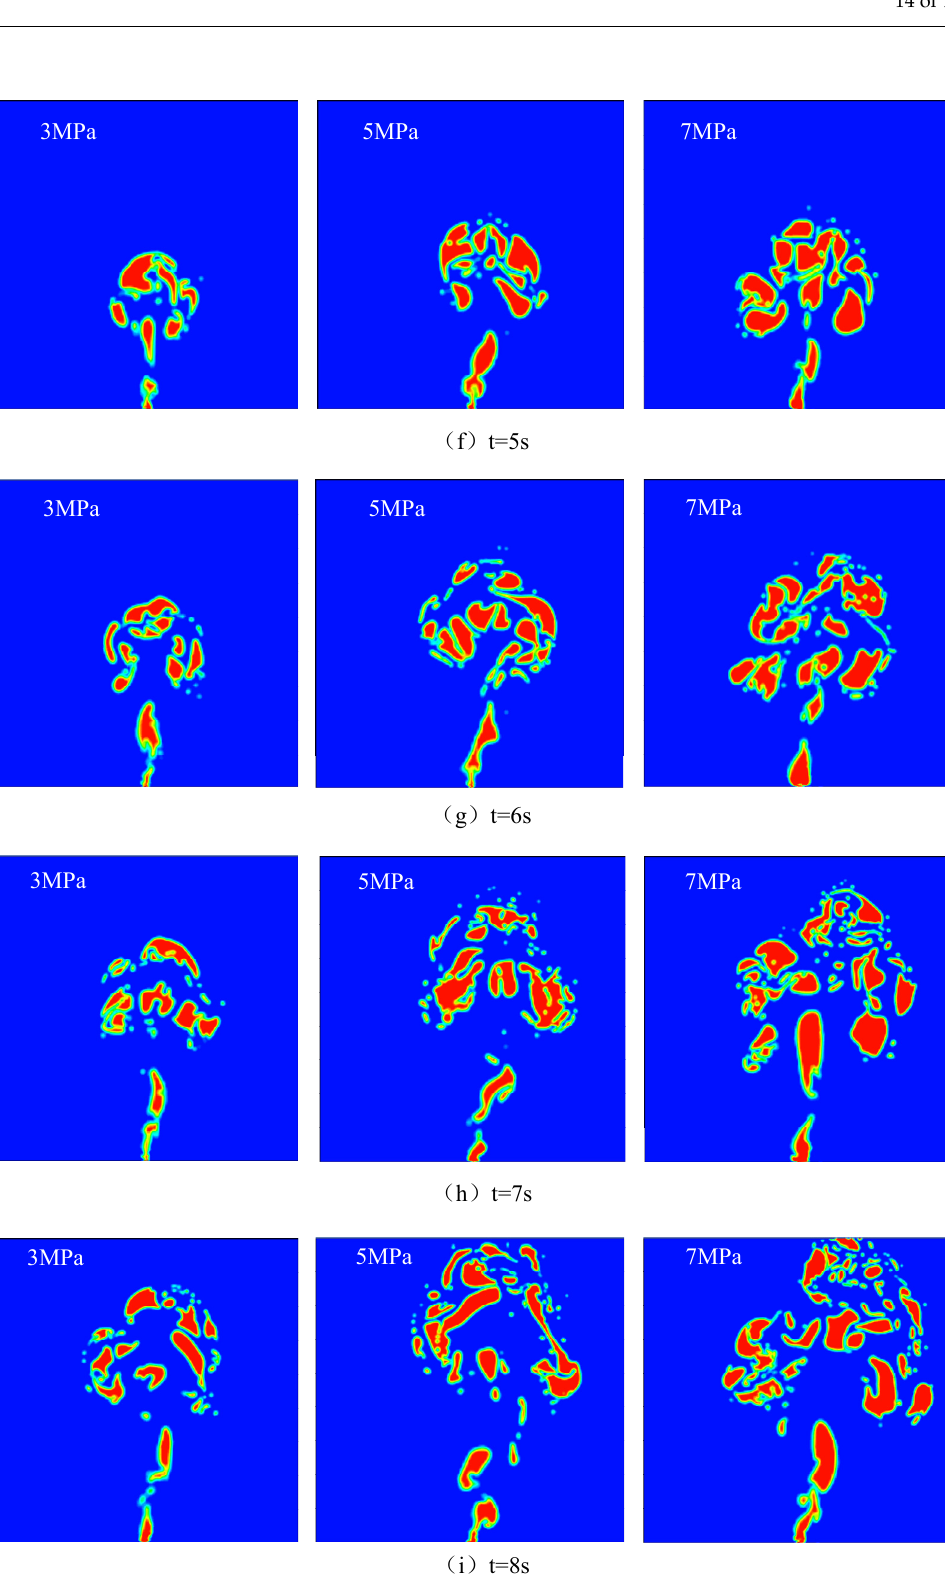
Figure 7. Nephogram of natural gas leakage and diffusion of submarine pipeline at each time when the pressures in the pipeline are 3 MPa, 5 MPa and 7 MPa, respectively.